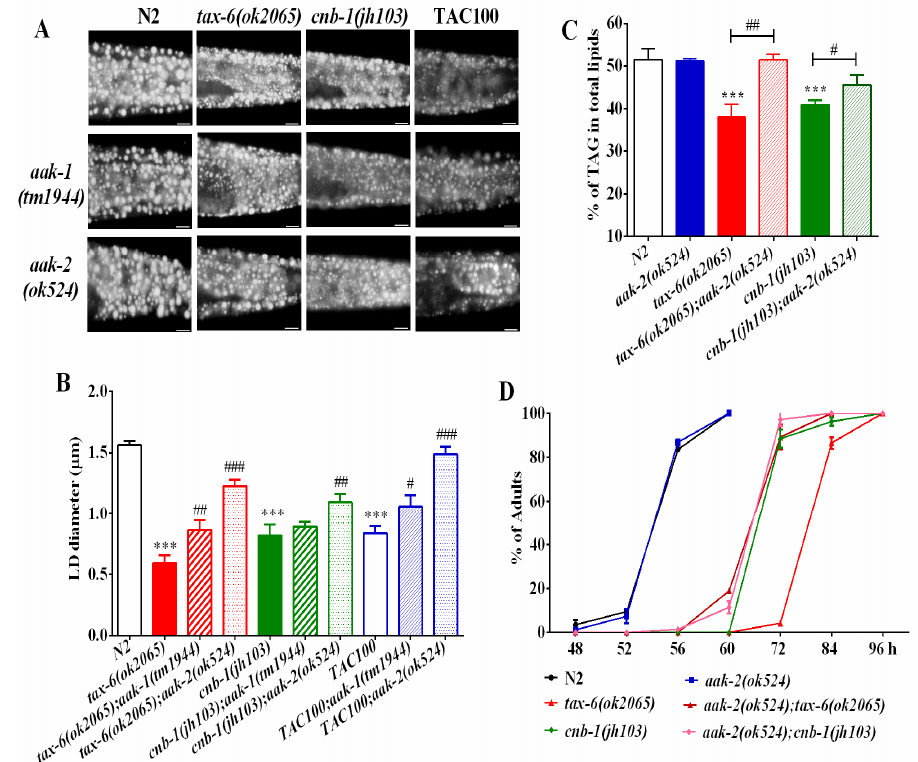
Figure 3. AMPK antagonizes calcineurin to regulate fat metabolism and growth rate. ( A ) Nile Red staining of fixed worms. Representative animals are shown with stained lipid droplets (LDs) in the posterior region. In all of the represented animals, the anterior is indicated on the left and the posterior is indicated on the right. Scale bar represents 10 μ m; ( B ) the average size of the lipid droplets (LD) were measured from Nile Red staining of fixed worms from (A). n = 10 for each worm strain; and ( C ) the percentage of triacylglycerol (TAG) in total lipids (TAG + phospholipids). Data are presented as the means ± SD of at least three biological repeats; and ( D ) the growth rate of worms. n > 200 worms. Data are presented as the means ± SD. * indicates significant difference between wild-type N2 and a specific worm strain, *** p < 0.001. # indicates significant difference between two indicated worm strains, # p < 0.05, ## p < 0.01, ### p < 0.001.